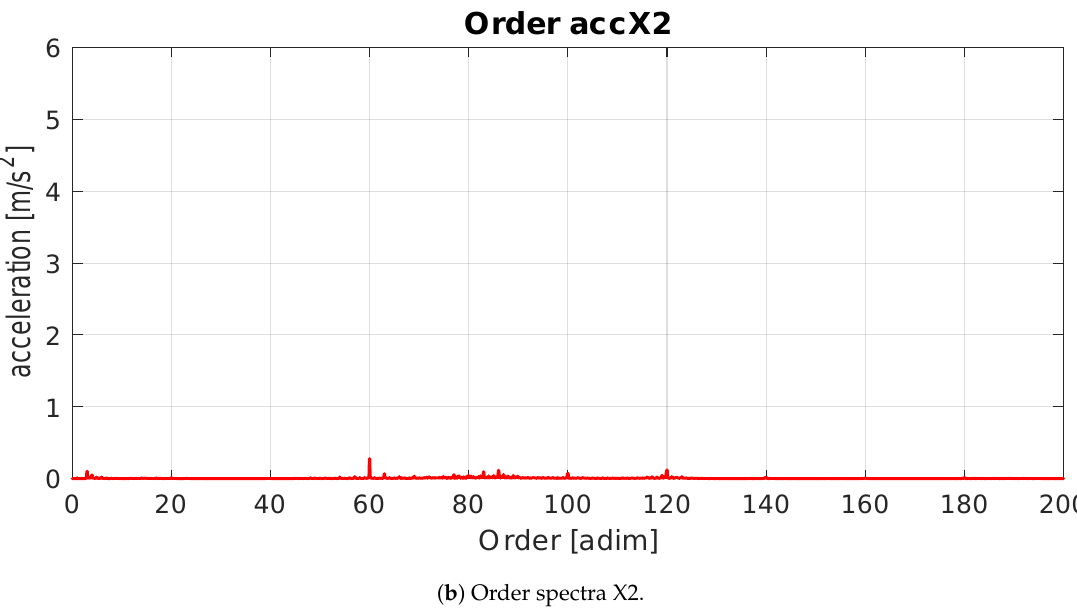
Figure 12. Comparison between spectra of layer 1 and layer 2 in x direction.